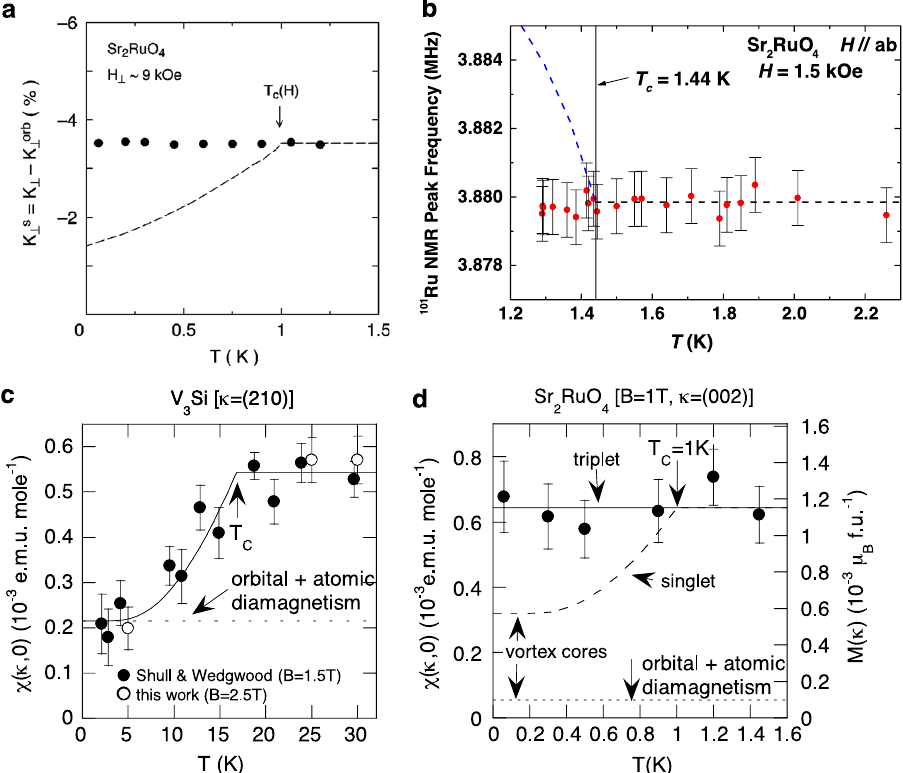
Fig. 4 a , b Two examples from the many studies that have been done of the Knight shift in Sr 2 RuO 4 . The examples shown are for 99 Ru nuclei a 73 and 101 Ru nuclei b , 74 for applied fi elds parallel to the RuO 2 planes (note that for 101 Ru, the peak frequency would increase as the spin susceptibility decreased, as sketched by the dotted blue line in b ). Extensive work has also been done using 17 O nuclei 70 and with variation of the applied fi eld direction. None of the experiments has shown a statistically signi fi cant decrease of the Knight shift below T c . c , d The spin susceptibility as deduced from inelastic neutron scattering for the known even parity superconductor V 3 Si ( c ) and Sr 2 RuO 4 ( d ). For V 3 Si the decrease originally predicted by Yosida 69 is observed, but for Sr 2 RuO 4 the neutron experiment also resolves no decrease below T c . 71